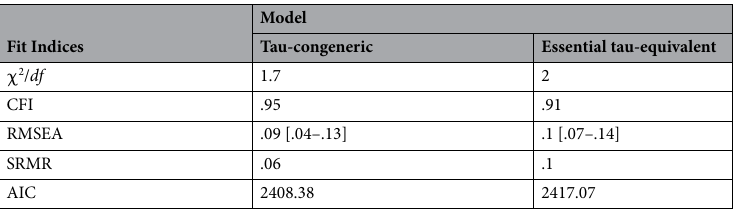
Table 5. Fit indices for both measurement models. CFI = comparative fit index; RMSEA = root-mean-square error of approximation (with 90% confidence interval in brackets); SRMR = standardized root-mean-square residuals; AIC = Akaike information